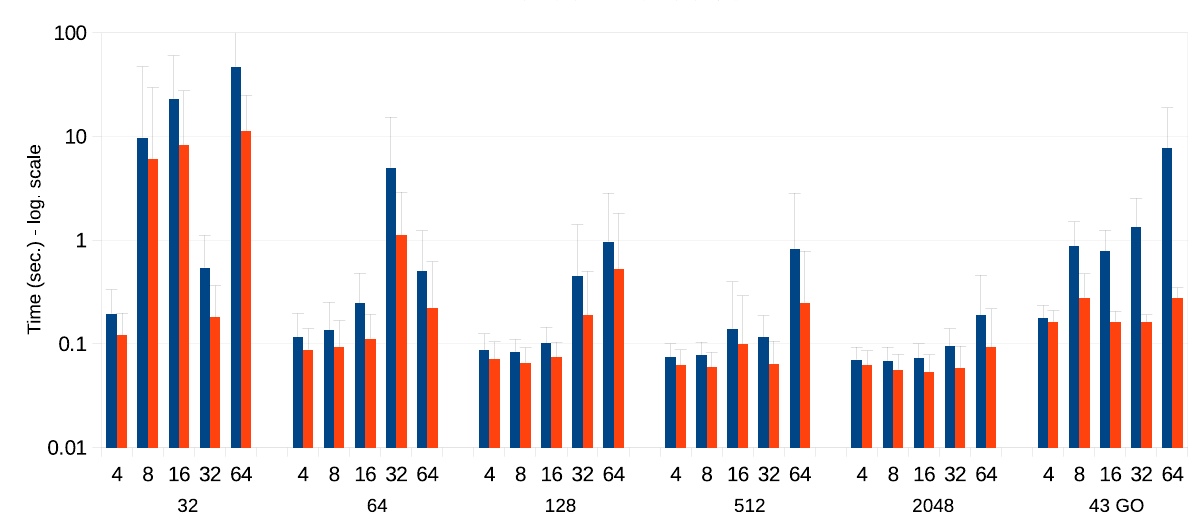
Figure 6. Query execution time on PPI